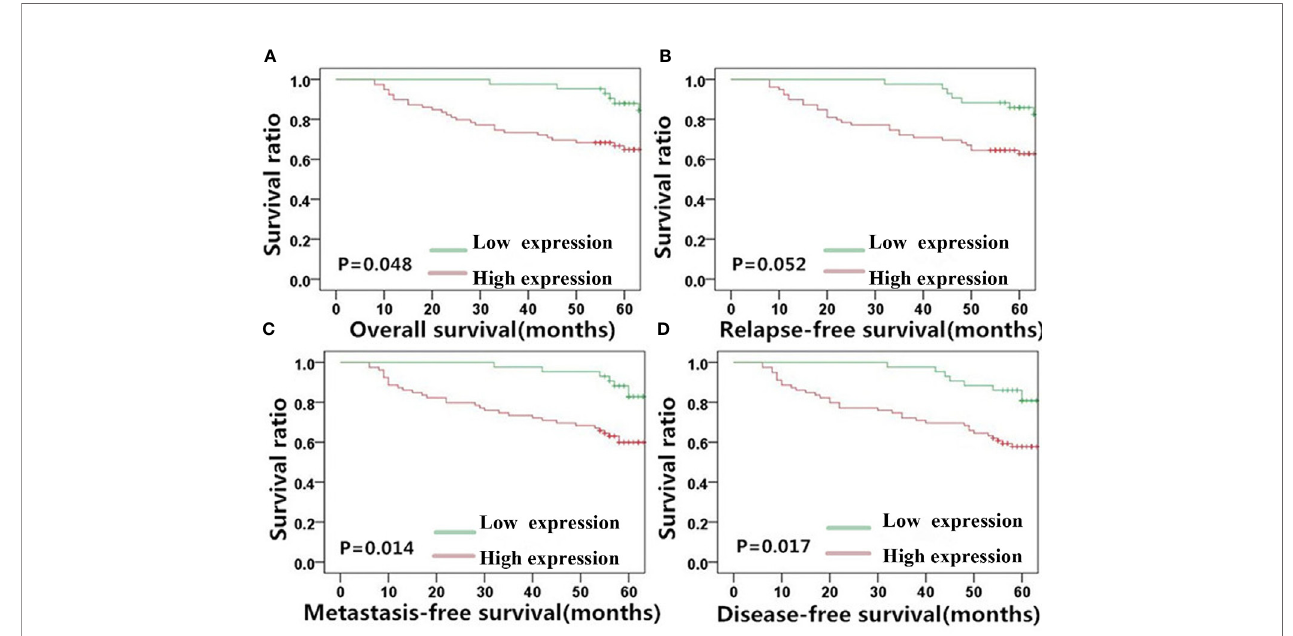
FIGURE 3 | MACC1 level is correlated with NPC patient survival outcome. Kaplan-Meier survival plots for (A) overall survival, (B) relapse-free survival, (C) metastasis-free survival, and (D) disease-free survival of the high (red lines) and low (green lines) MACC1 expression groups. MACC1, metastasis- associated in colon cancer 1; NPC, nasopharyngeal carcinoma.